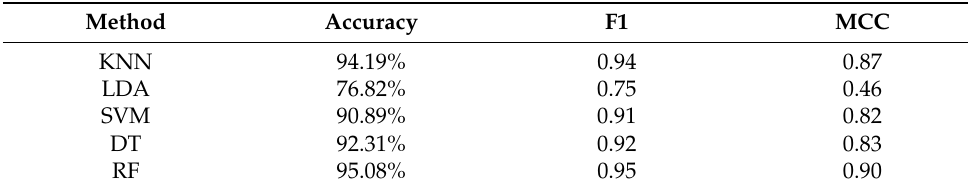
Table 6. Average accuracy of ML algorithms.